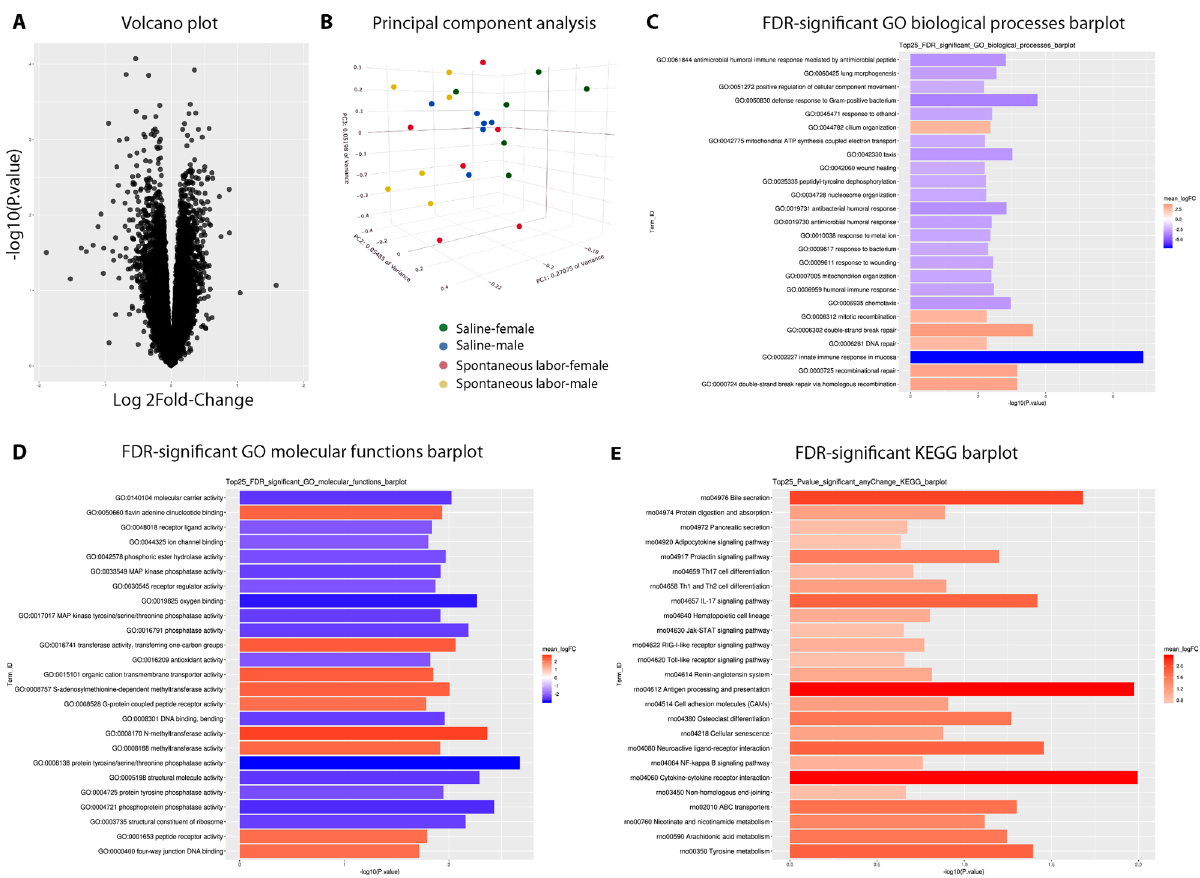
Figure 4. Impact of anesthesia and surgery on the newborn cortical transcriptome. ( A ) Volcano plot showing the absence of significantly differentially expressed genes between the spontaneous labor vs. saline pump groups (n = 6/treatment condition from 3 litters each). ( B ) Principal component analysis (PCA) showing that the major source of variance is not the treatment condition but the sex of the offspring, albeit not significant (green: saline/ female, blue: saline/male, red: spontaneous labor/female, yellow: spontaneous labor/male). ( C , D ) Top 25 false discovery rate-adjusted significantly up- and downregulated genes for Gene Ontology (GO) biological processes (C) and molecular functions (D) after labor induction with Oxt. ( E ) Significantly upregulated genes with Kyoto Encyclopedia of Genes and Genomes (KEGG) analysis. GO and KEGG analyses revealed a differential impact of anesthesia and surgery on multiple pathways, mostly related to oxygen binding and the immune response, respectively. Therefore, for the rest of our experiments, we used saline pump-implanted dams that eventually labored spontaneously as controls, instead of dams that labored spontaneously without exposure to anesthesia and surgery. The mean log twofold-change in the GO and KEGG barplots are the mean log twofold-change of the genes within the term versus the mean log twofold-changes of the genes in the background using the GAGE method of testing log twofold-changes for perturbations in